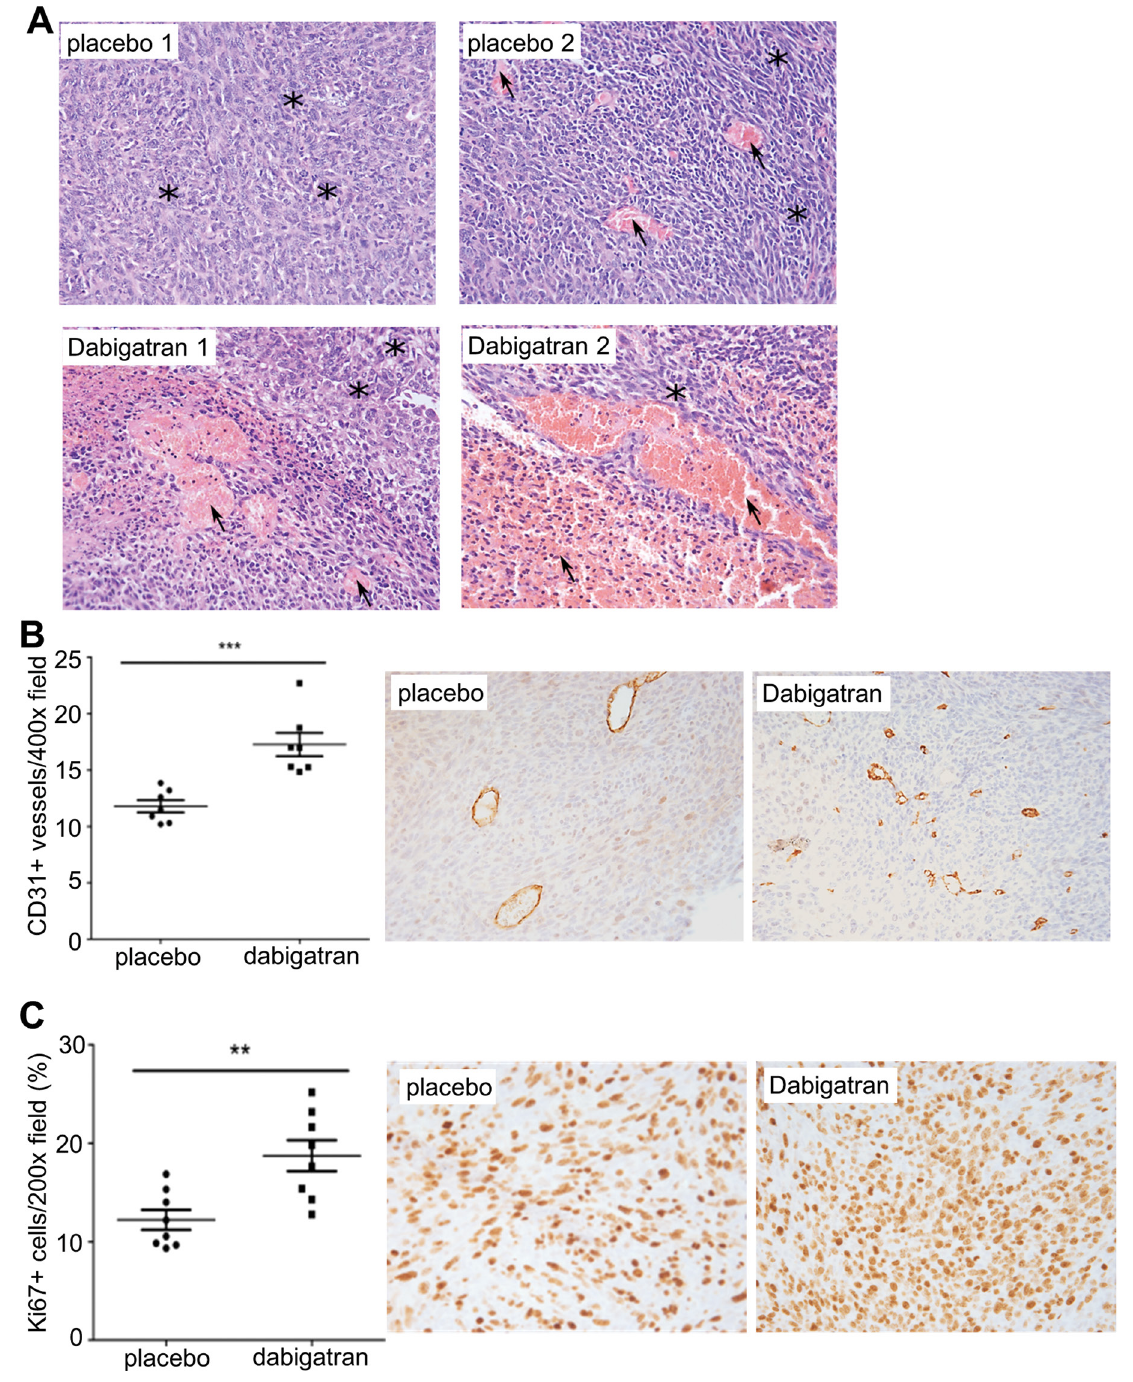
Figure 2. Dabigatran monotherapy is associated with angiogenesis and tumor cell proliferation. (A) H&E-stained pancreatic cancer sections obtained from placebo or dabigatran-treated mice. Representative pictures were taken at magnification of 200 ×, * indicates tumor tissue and arrow indicates red blood cells. (B and C) Paraffin sections obtained from placebo or dabigatran-treated mice stained for (B) CD-31 (blood vessel formation) and (C) Ki-67 (proliferation). Right panels show quantifications of the sections depicted in the left panels. Representative pictures were taken at 200 ×